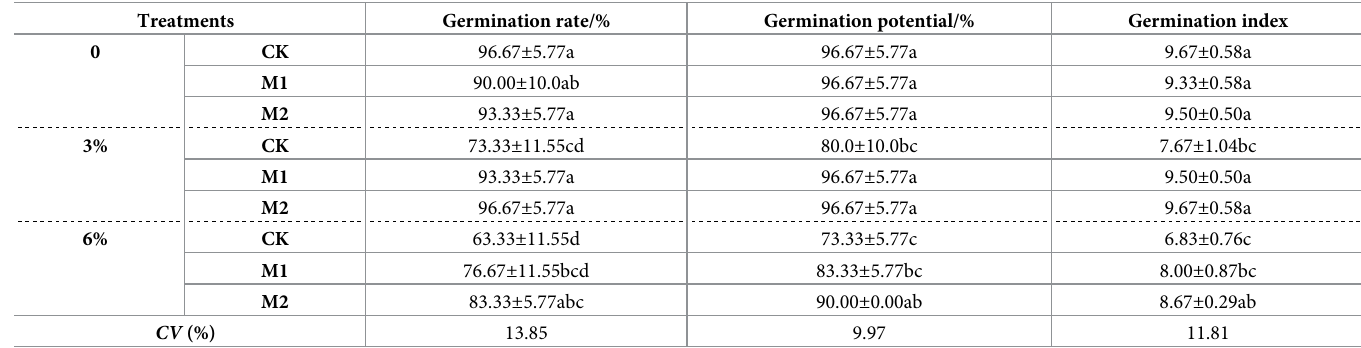
Each value indicated is the means of three replicates recorded ± S.E. Means followed by the same letters are not significantly different at P � 0.05 within the same column. CV: Coefficient of